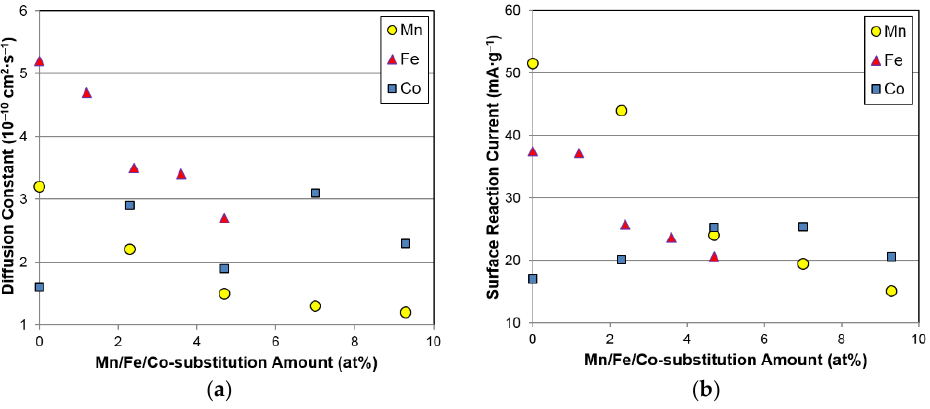
Figure 10. Changes in ( a ) bulk diffusion constant ( D ) and ( b ) surface reaction current ( I o ) with increasing substitution amounts.